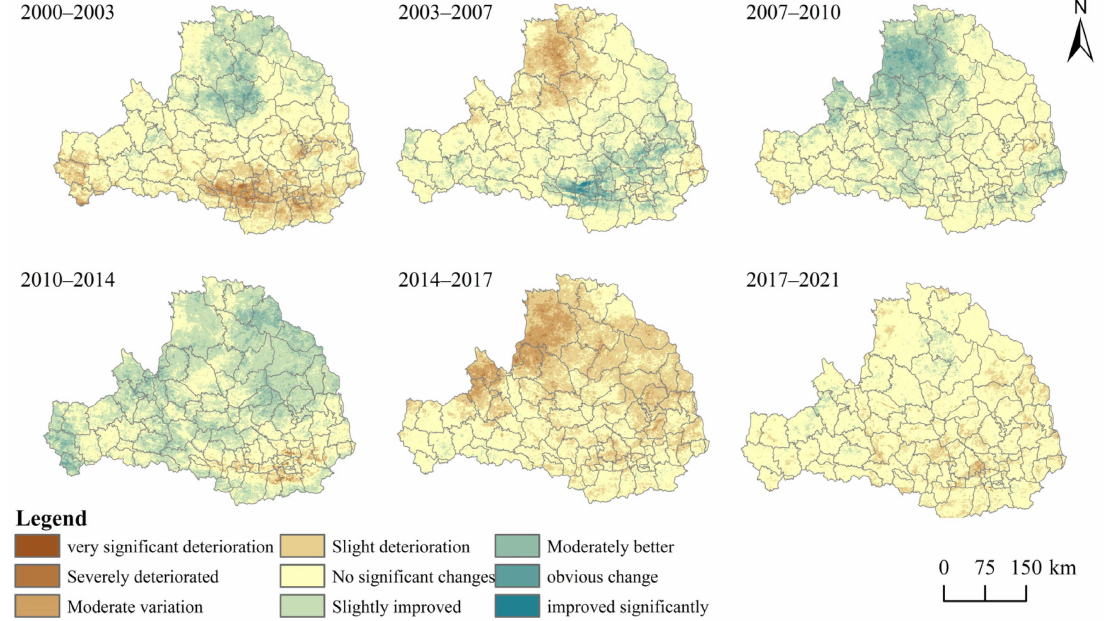
Figure 5. Spatial variations in the RSEI classes in the Weihe River Basin during